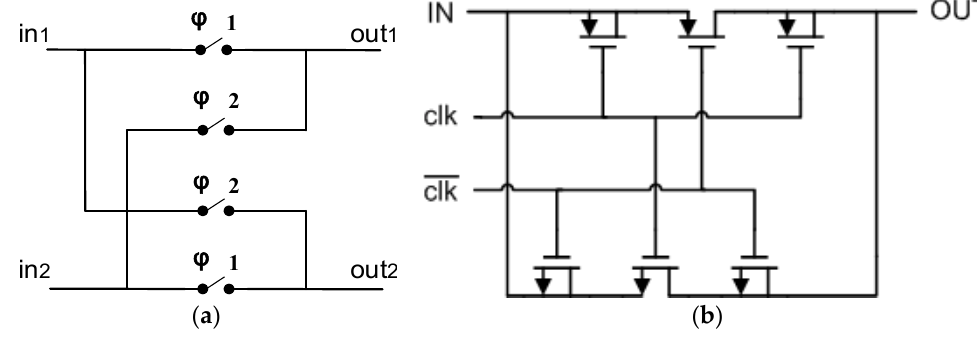
Figure 4. ( a ) Chopper modulation topology; ( b ) Switch topology.